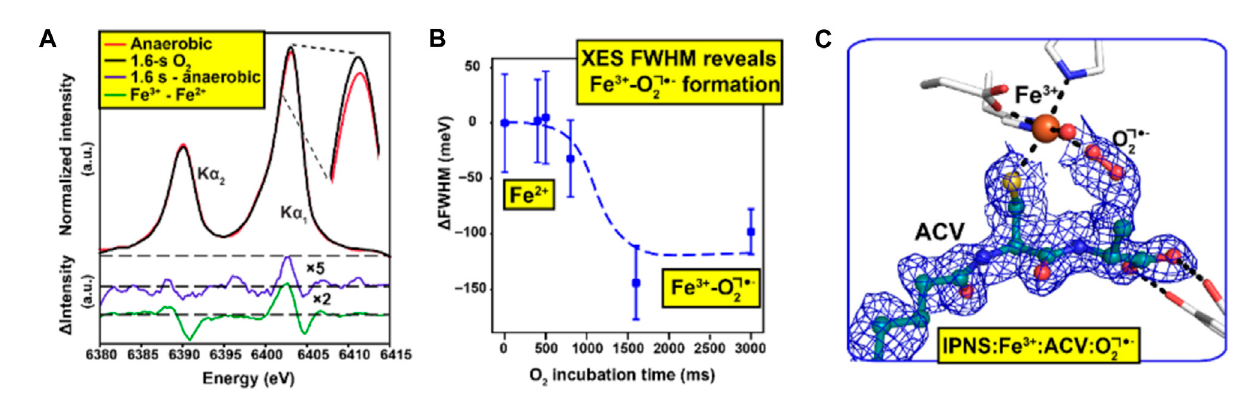
FIGURE 2 Combination of spectroscopic and XFEL data to understand ligand binding [ d -(L- α -aminoadipoyl)-L-cysteinyl-D-valine (ACV) and O 2 ] to the enzyme isopenicillin N -synthase(Rabeetal.,2021).Initial XFELdatawereobtained fortheenzymewiththesubstrateACV,aprecursortoforall naturalcephalosporins and penicillins. Reactivity within microcrystals was initiated by passing them through an O 2 chamber and SFX data were measured in a time-dependent manner. X-rayemission spectroscopy(XES)data (A) wasobtained usingthesameX-raypulsethatgeneratedthediffractionpatternsallowingatwo-step (cid:129) − transition between the resting states Fe(II) and intermediate Fe(III)-O 2 states to be characterised over a wide range of reaction times (B) SFX data were (cid:129) − obtained at a time point of 1,600 ms such that the Fe(III)-O 2 intermediate had fully formed (C) Figure adapted from (Rabe et al.,